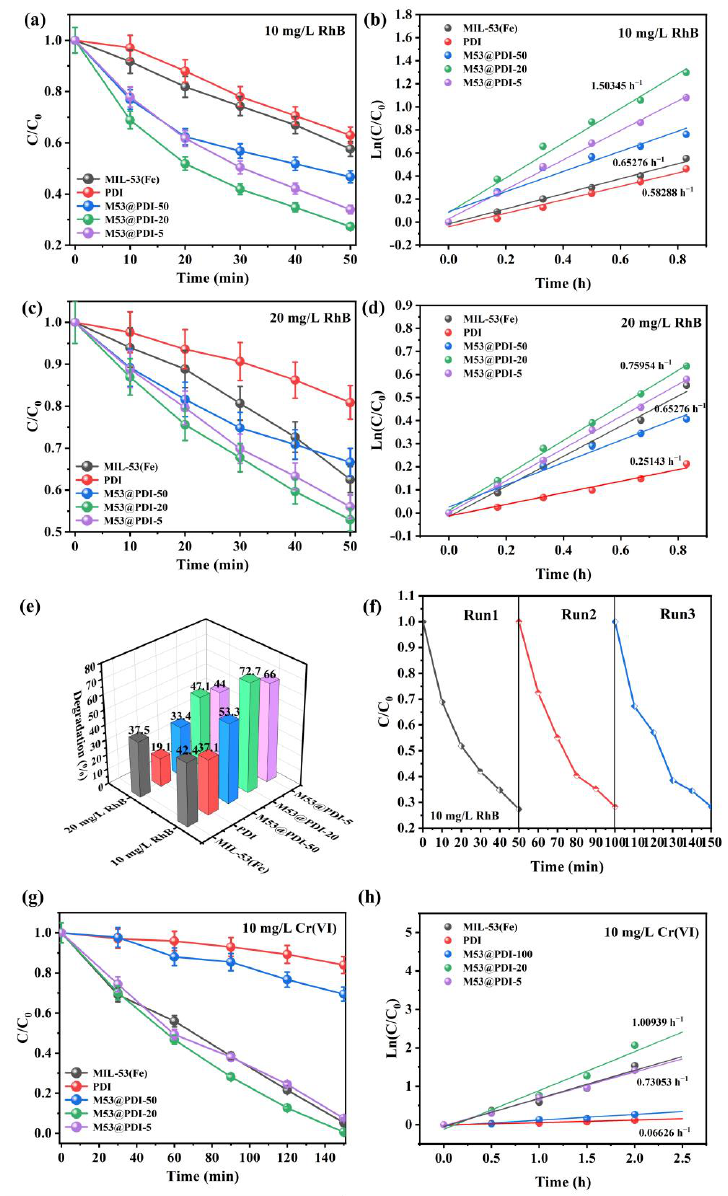
Figure 5. Photocatalytic capabilities for the degradations of ( a , b ) 10 mg/L, ( c , d ) 20 mg/L RhB, and the reduction of 10 mg/L Cr(VI) solution, ( e ) RhB removal rates over all samples, ( f ) the cycling degradation of 10 mg/L RhB on M53@PDI-20 and ( g , h ) over PDI, MIL-53(Fe) and MIL-53(Fe)@PDI heterojunctions under 400 W metal halide lamp irradiation, respectively.